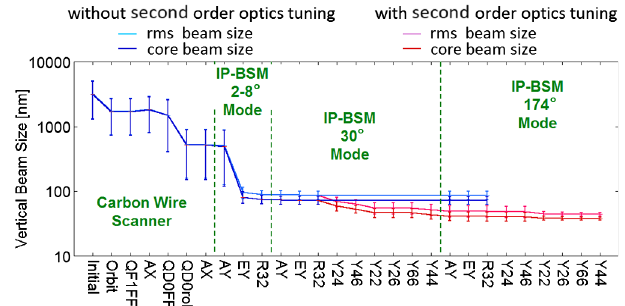
FIG. 14. The simulated results of beam size changes throughout the beam tuning process with and without second order optics knobs for the 1 × 1 optics. “ rms beam size ” is the standard deviation of the y distribution of the tracked particles at the IP. “ Core beam size ” is the width of a Gaussian function fitted to the core of this distribution.